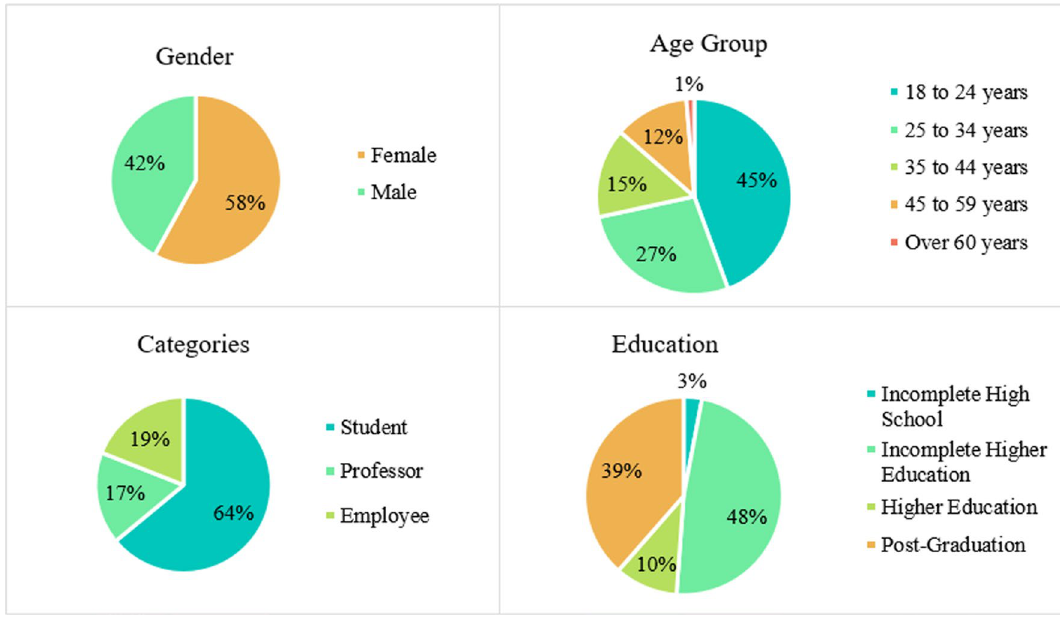
Fig. 1 Sample characteristics: gender, age group, category of classification and education